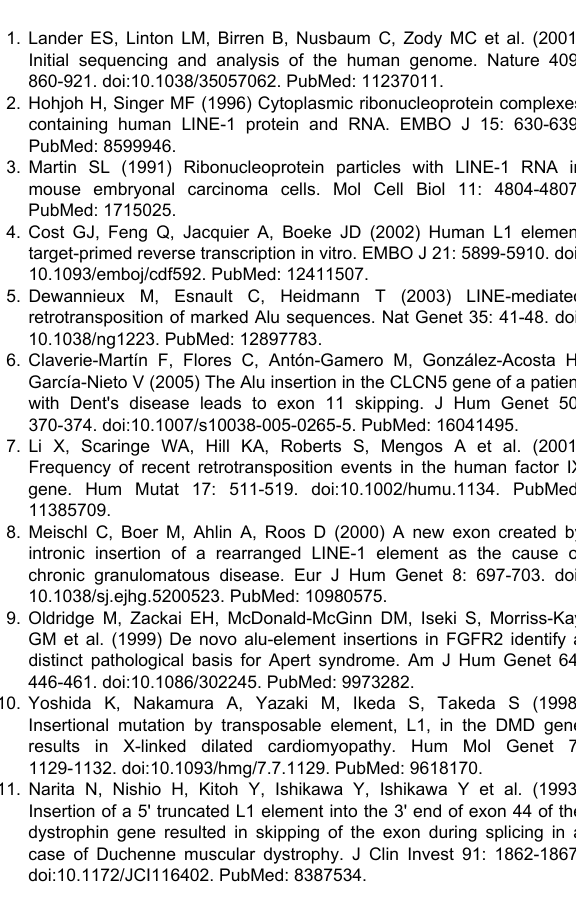
performed as described in Figure 1. Crystal violet-stained G418 R colonies were counted to determine the level of Alu retrotransposition. The data shown are the mean ±SD of triplicate experiments. Mo, mock; WT, wild-type hA3G; GFP, (TIF) Figure S4. Inhibitory effect of hA3G oligomerization mutant proteins on HIV-1 infection. The assay was performed as described in Figure S1. The data shown are the mean ± SD of triplicate experiments. RLU: relative light units.